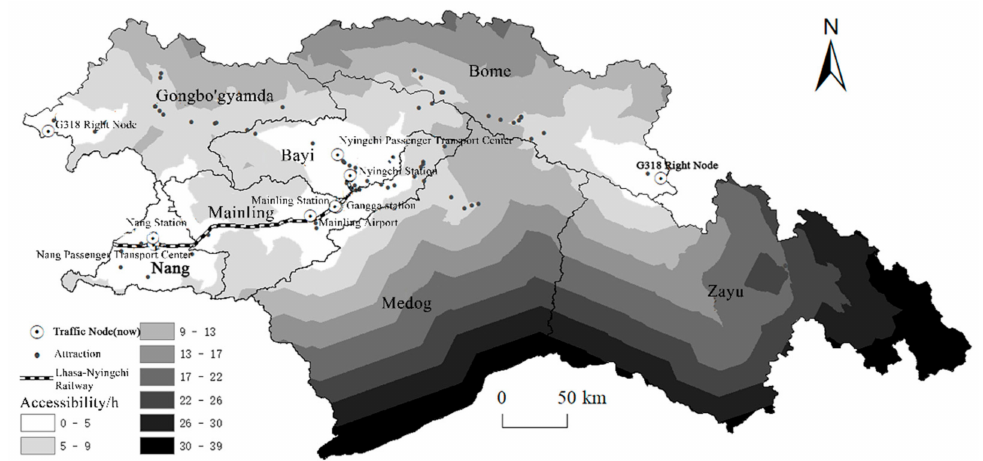
Figure 4. The current accessibility with traffic nodes as the core. Note: This map is based on the standard map of the Map Technical Review Centre of the Ministry of Natural Resources of China (Number: GS (2019)4342), with no modifications to the base map. Map-making by the author. At present, in terms of the “0–2 h” accessibility circle, Bayi District, as the central urban region of Nyingchi, is the geographic and geometric center of Nyingchi and also the region with the highest accessibility. Different from the traditional distribution of accessibility that decreases outwardly from the center, and due to the terrain restrictions of the high mountains and valleys, the accessible region within 2 h, the “multi-core